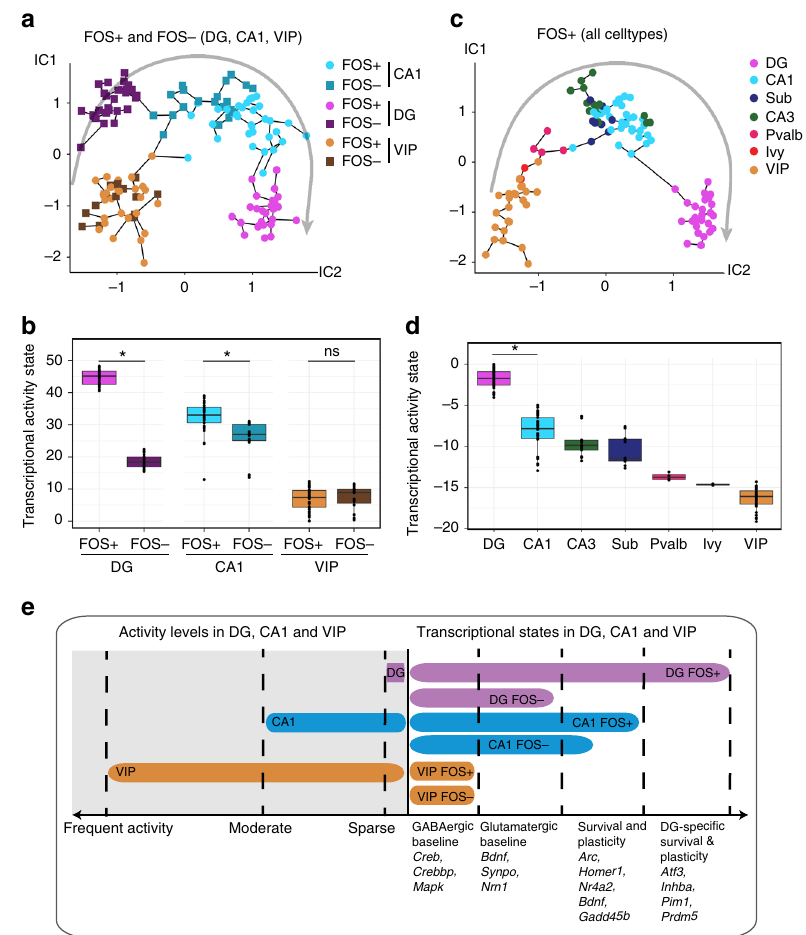
Fig. 3 DG neurons exhibit a unique transcriptional signature following NE exposure. a , b Activity-dependent genes were used to construct an independent components (IC) plot using Monocle for DG, CA1, and VIP nuclei after exposure to a NE. a Nuclei are colored with respect to cell type. Arrow indicates the direction of increasing Arc expression. b Position along the main trajectory for each group of neurons. Transcriptional activity state ( y -axis) = pseudotime as calculated by Monocle. * = t -test p -value < 0.05, ns = not signi fi cant. c , d Activity-dependent genes were used to construct a second independent Monocle plot for FOS + neurons from all cell types. c Each cell is colored with respect to cell type. Arrow indicates the direction of increasing Arc expression. Sub = Subiculum, Pvalb = Parvalbumin interneuron. d Position along the main trajectory for each group of FOS + neurons. * = Student ’ s t -test